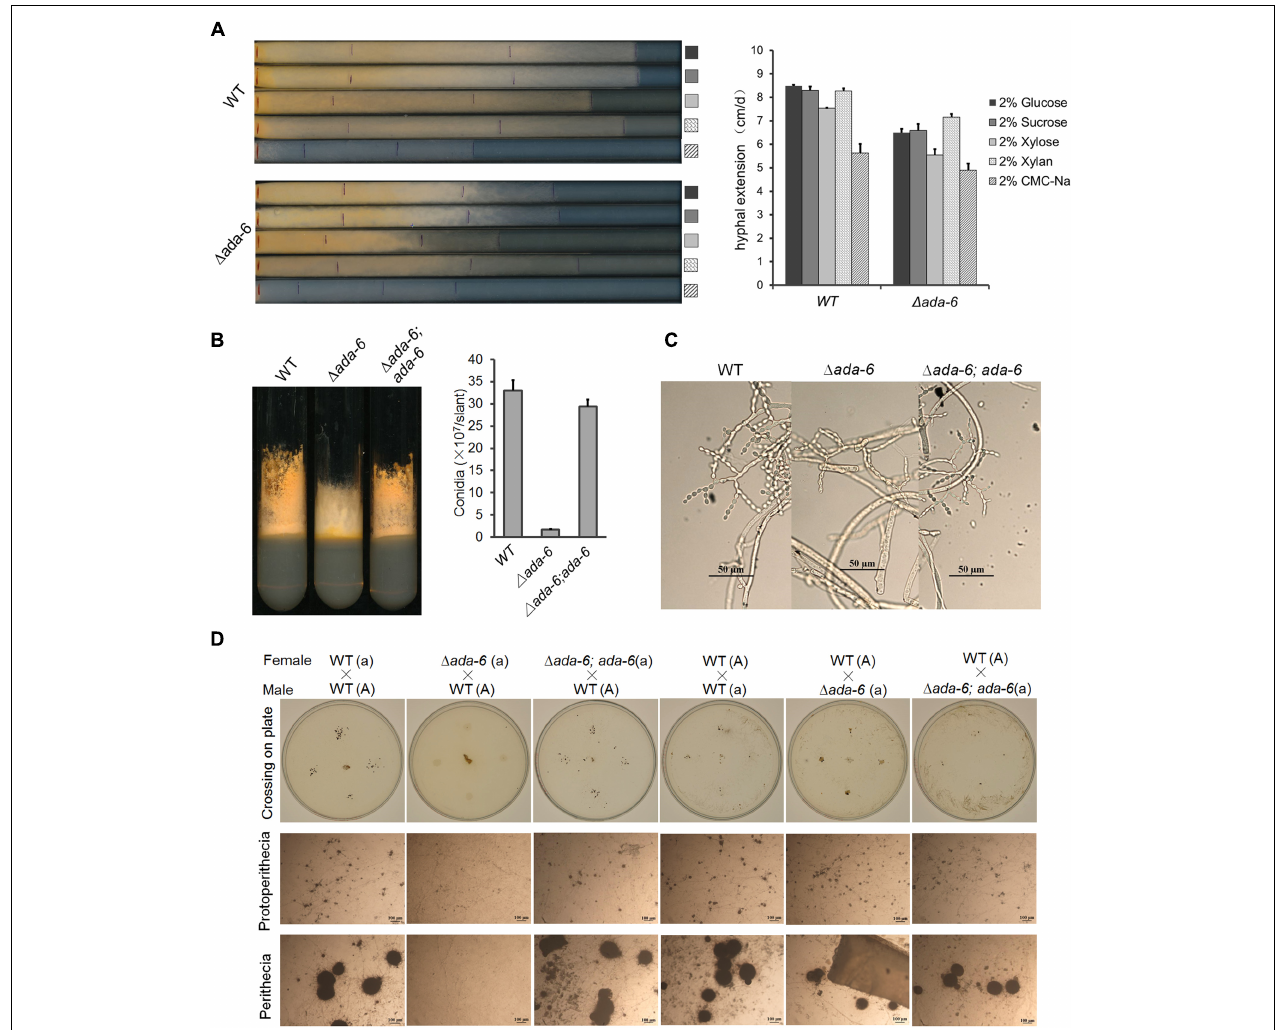
FIGURE 1 | Deletion of ada-6 results in reduced hyphal growth, less conidial production, and female sterility in N. crassa . (A) Hyphal growth characterization of the ada-6 deletion mutant ( (cid:49) ada-6 ) and wild type (WT) grown with different carbon source. Strains were grown in race tube containing solid Vogel’s medium with different carbon sources. Inoculated race tubes were incubated at 28 ◦ C and the leading edge of the colony were marked every 24 h. The hyphal extension was then measured by a ruler. The means of hyphal extension rates from three race tubes are shown and standard deviations are indicated by error bars. (B) Conidiation characterization of wild type (WT), the ada-6 deletion mutant ( (cid:49) ada-6 ) and it’s complemented transformant ( (cid:49) ada-6; ada-6 ). Strains were grown in Vogel’s slants at 28 ◦ C with continuous light for 7 days and then imaged. Conidia produced on slants were counted with a hemocytometer. The means of conidial counts from three slants are shown and standard deviations are indicated by error bars. (C) Conidiophore structure of wild type (WT), the ada-6 deletion mutant ( (cid:49) ada-6 ) and it’s complemented transformant ( (cid:49) ada-6; ada-6 ). Bar, 50 µ m. (D) Protoperithecium and perithecium formation by crossing of the ada-6 deletion mutant ( (cid:49) ada-6 , a) with wild type (#2225, A). The ada-6 deletion mutant ( (cid:49) ada-6 , a) or wild type (#2225, A) were used as female parent and first grown on solid crossing medium for 5 days under constant darkness at 25 ◦ C, then the opposite mating type strain was inoculated as male parent and incubated at 25 ◦ C for another 7 days under constant darkness. Protoperithecium and perithecium formation was checked and